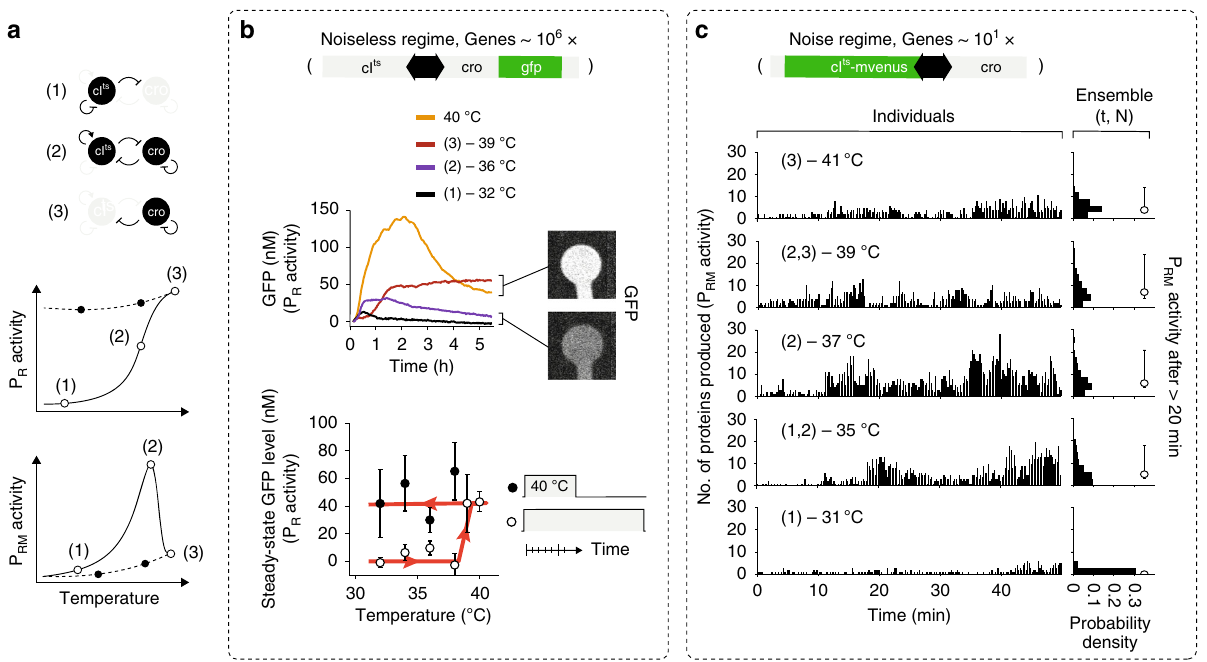
Fig. 2 Bistable GRN and decision-making at high and low gene densities. a Illustration for the expected output of P R and P RM activity as a function of temperature, based on the known molecular feedbacks of the GRN. b Dynamics of GFP expression reporting on the P R activity at high DNA density (upper panel). Solid lines depict average dynamics, N = 24. (1), (2), and (3) relate to molecular states of the bistable GRN at each temperature, as in panel a. Steady-state GFP levels averaged over individual compartments (lower panel). Temperature was either kept constant throughout the measurement (open circle) or after a 40 °C initial incubation step (closed circle). Error bars show the mean and standard deviation (SD) of compartments. Red line drawn to guide the eye. c Number of CI ts -mVenus produced in 15 s to give production rates (left column) and ensemble distribution over time t and compartments N after >20 min (right column) in the low-density regime. Circle with error bars give the median and 32th to 68th percentile of the ensemble production rates ( N = 1044, 696, 1044, 2088, 1044 in the order of increasing temperature). Source data are provided as a Source data fi